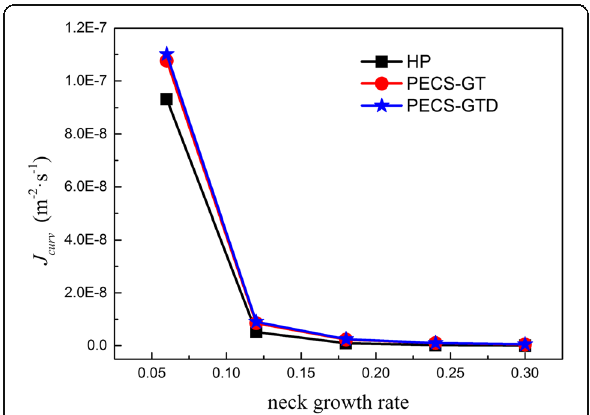
Fig. 4 Comparison of vacancy diffusion flux under volume